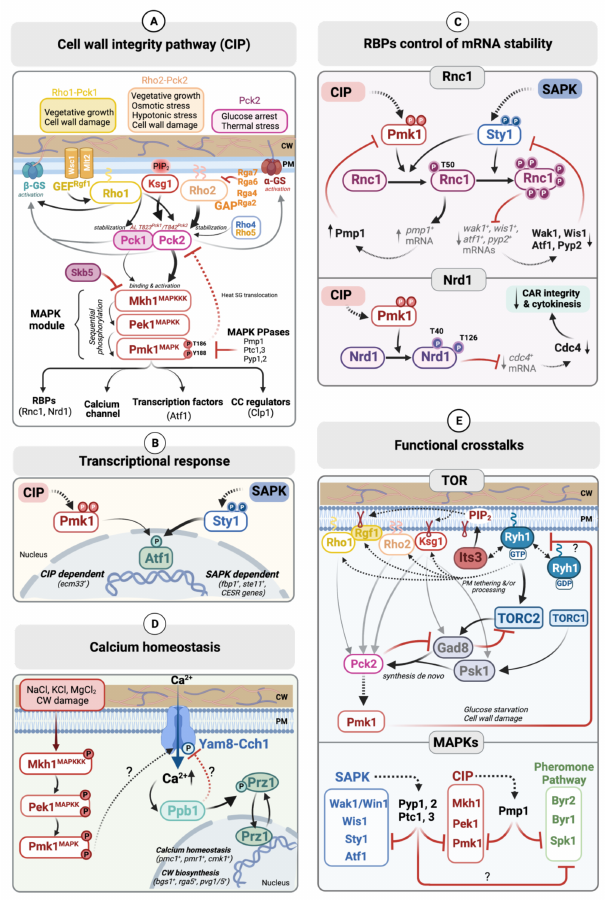
Figure 1. Organization and biological roles of the fission yeast Cell Integrity Pathway (CIP) . ( A ) The overall architecture and main components of the CIP in S. pombe . ( B ) Transcriptional